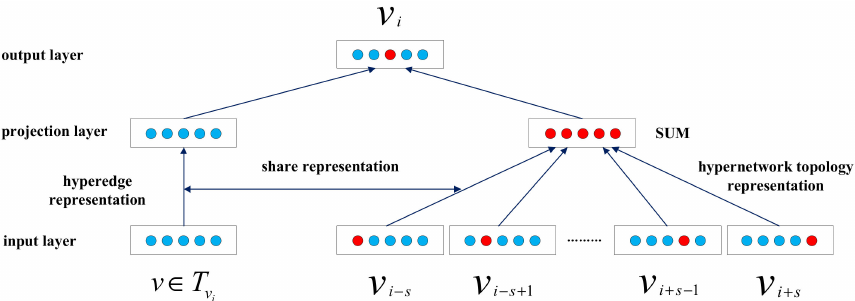
Figure 2. HRSC framework, where v i is the center node, other nodes v i − s , v i − s + 1 , v i + s − 1 , v i + s , etc. are contextual nodes of the center node v i , namely context ( v i ) , where the vectors corresponding to v i − s , v i − s + 1 , v i , v i + s − 1 , v i + s are denoted as the first red dot from the left, the second red dot from the left, the red dot in the middle, the second red dot from the right, the first red dot from the right, SUM denoted as all red is the summation of all of the vectors corresponding to context ( v i ) , and T v set of hyperedges associated with the center node v i , and also the set of the nodes associated with the center node v i if the hyperedge is regarded as the